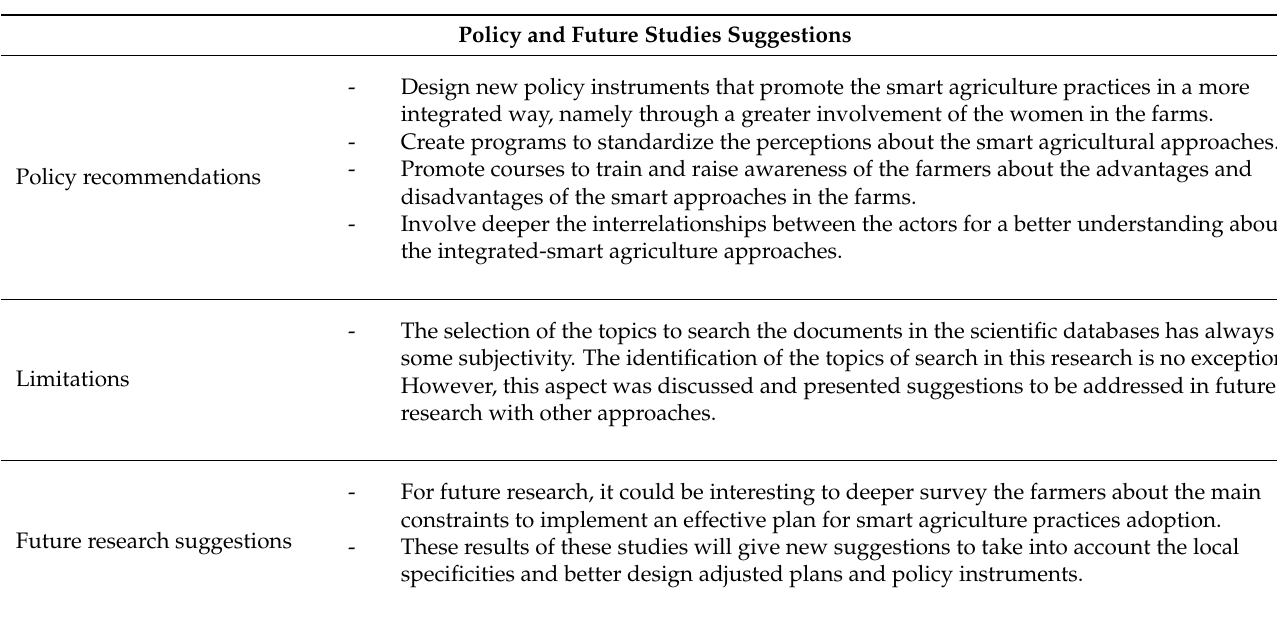
Table 5. Policy recommendations, limitations, and future